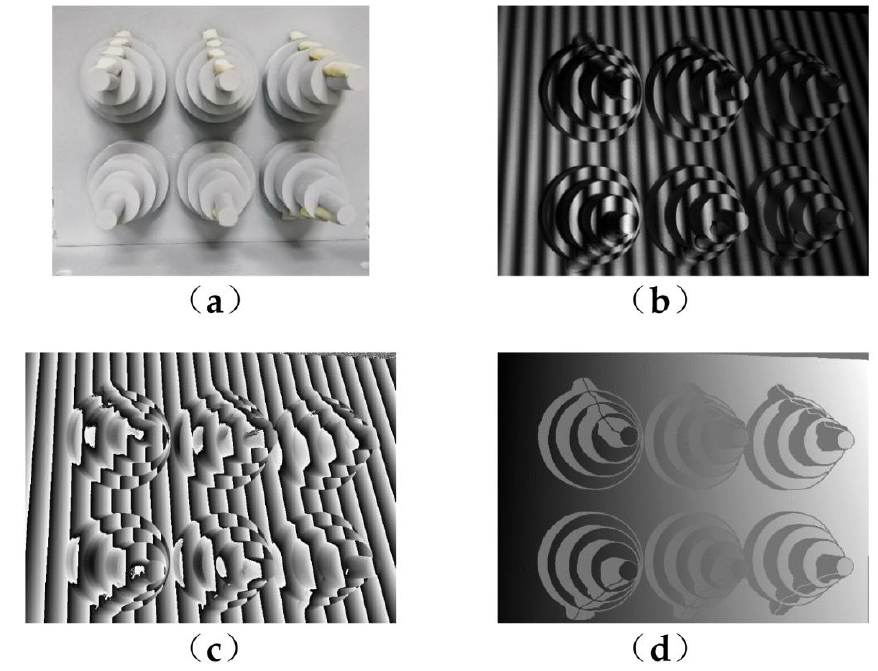
Figure 11. System calibration process: ( a ) standard block. ( b ) deformed fringe pattern on block captured by the camera, ( c ) wrapped phase distribution calculated by TFTP, ( d ) unwrapped phase distribution.